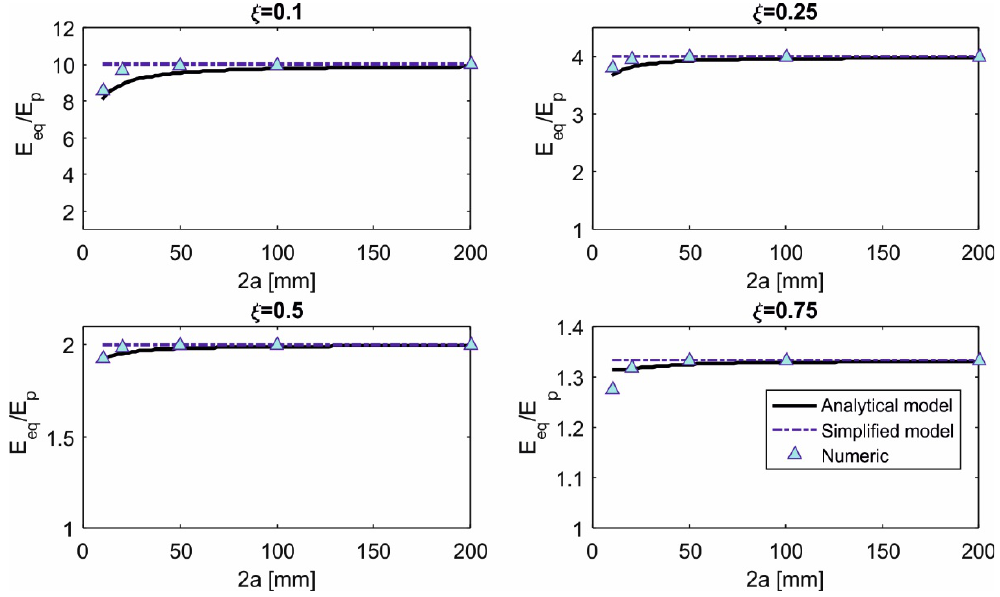
Fig. 3 Ratio E eq / E p , as a function of the fragment length 2 a , for interlayer thickness 0.76 mm and for different values of ξ = λ / a . Comparison between analytical and numerical